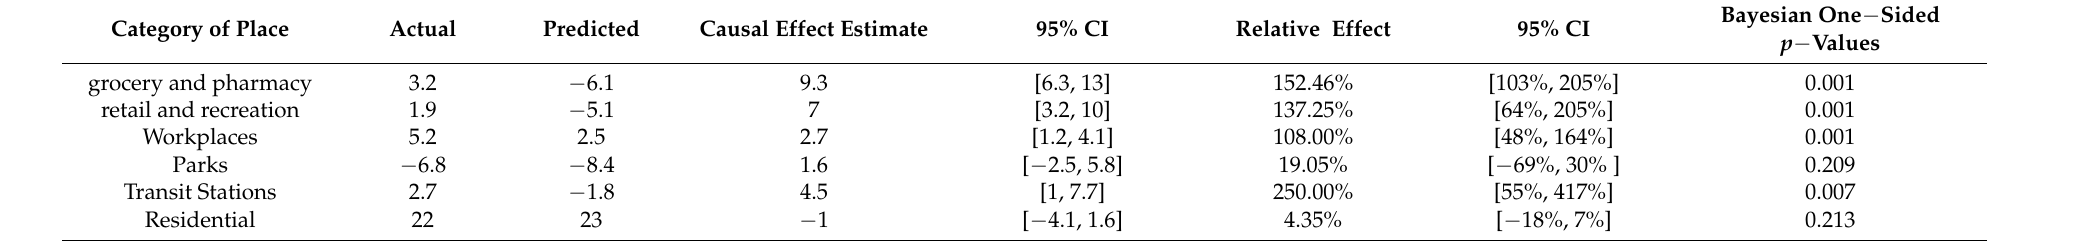
Table 6. Causal effect of lockdown Level 3 implemented 1 June 2020, for each category of